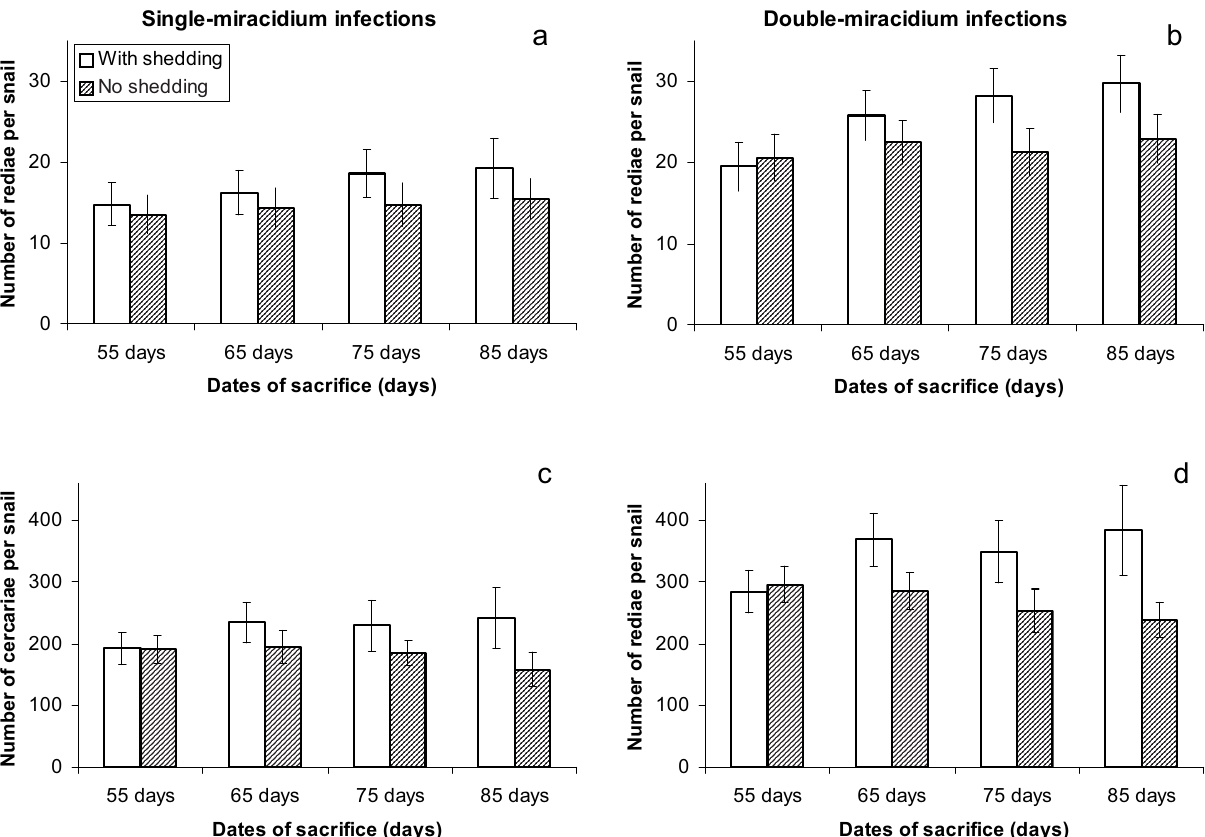
Fig. 2. – Mean values and S.D. for the number of P. daubneyi rediae (a, b) and that of cercariae (c, d) in single-miracidium infections of G. truncatula (a, c) and in double-miracidium ones (b, d) in relation to the length of experiment and the existence or the absence of cer- carial shedding before each date of snail